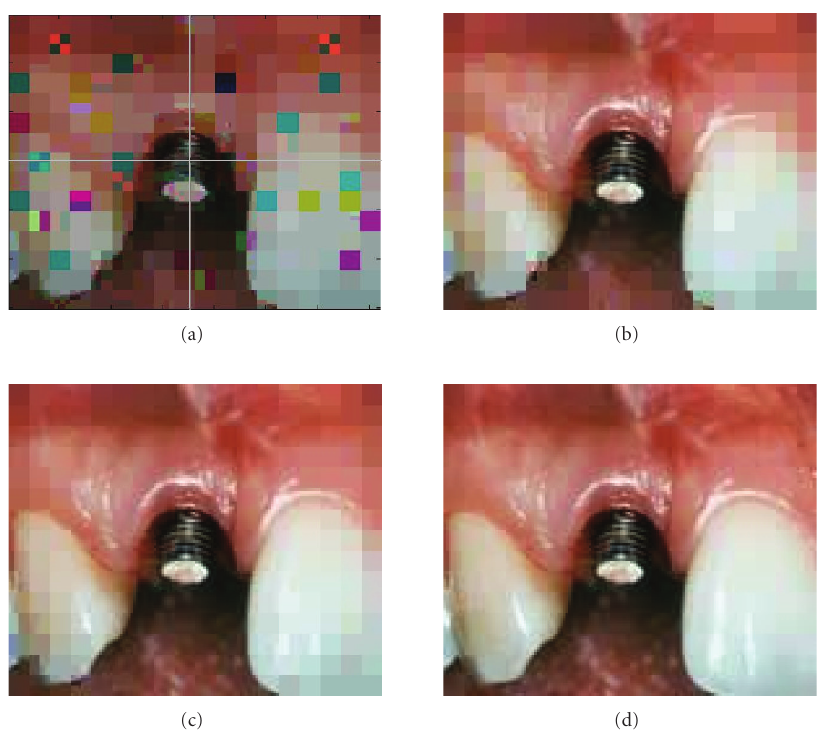
Figure 12: The decoded image with variable length of parity codes over the noisy channel. (a) A background image and the location of RoI selected in the center of image reconstructed after stage P 1 , (b) the reconstructed image after stage P 2 , no error subblocks are found in the reconstructed image because the lengths of parity codes are adjusted automatically based on the previous volume of incorrect data in the receiver, (c) the reconstructed image after stage P 3 ; the lengths of parity bits in stage 3 are as same as in stage 2 because no incorrect data was found in the reconstructed image after stage 2, (d) the complete transmitted image with no error